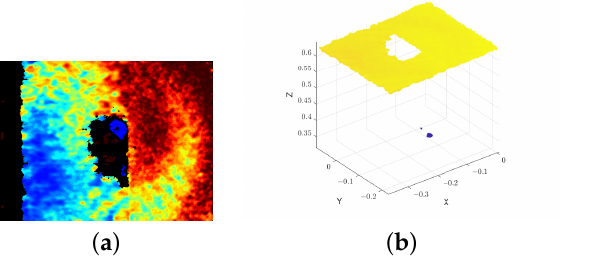
Figure 12. Example of a depth frame from the acquisition D415— empty converted to a point cloud. ( a ) Depth frame (by D415 camera) colorized in the function of depth values. ( b ) Point cloud.